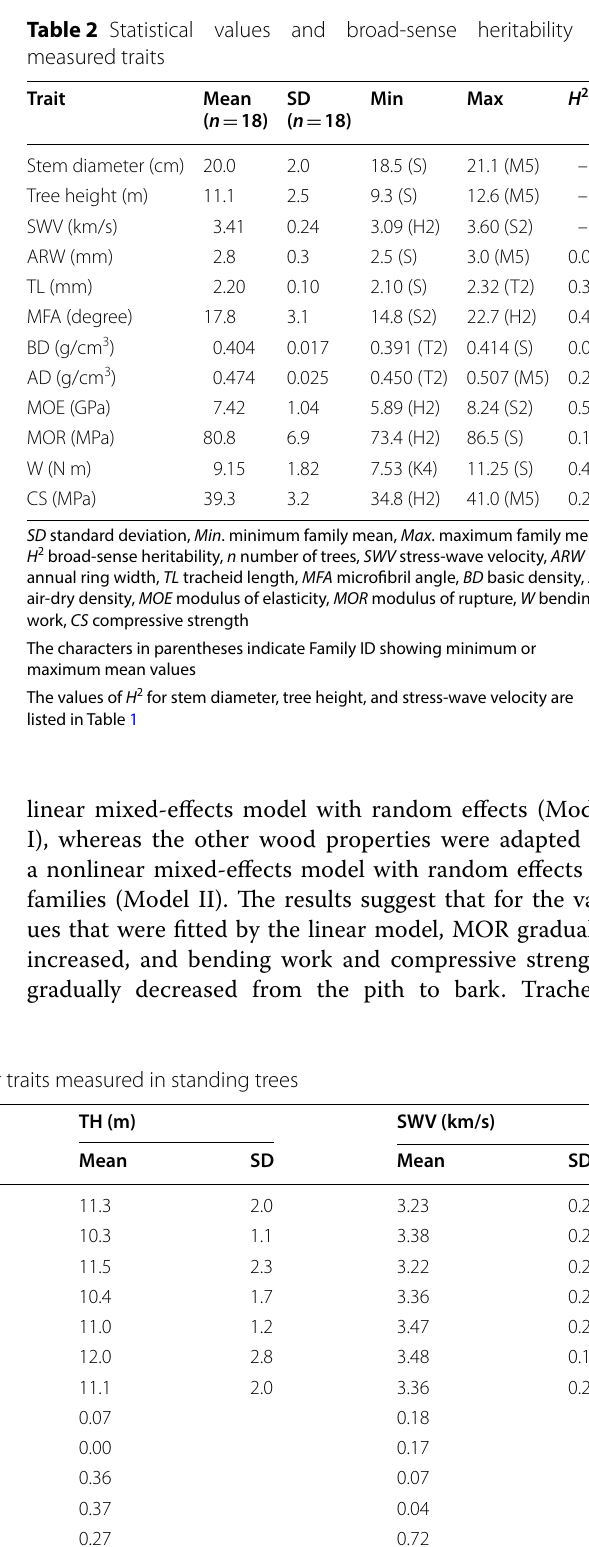
n number of trees, D stem diameter at 1.3 m above the ground, TH tree height, SWV stress-wave velocity, SD standard deviation, H 2 broad-sense heritability V f , V b , V fb , and V r represent variance components ratio of family, block, interaction between family and block, and residual, respectively